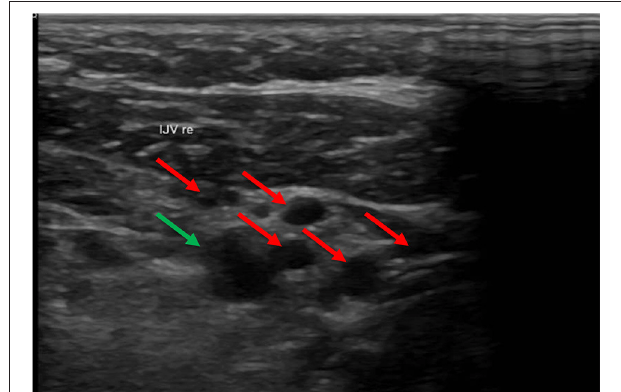
FIGURE 5 | In this ultrasound image the carotid artery (green arrow) is surrounded by many collateral veins (red arrows) due to occlusion of the IVJ. In this ultrasound, the carotid artery is in the upper right part of the image. The small vessels surrounding the artery are collateral veins. The internal jugular vein (IJV) was